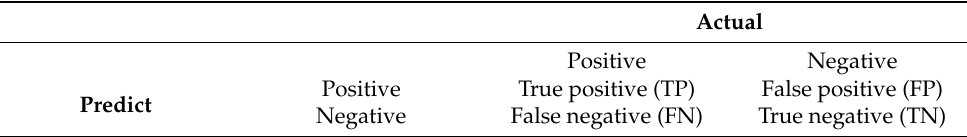
Table 4. Confusion matrix.